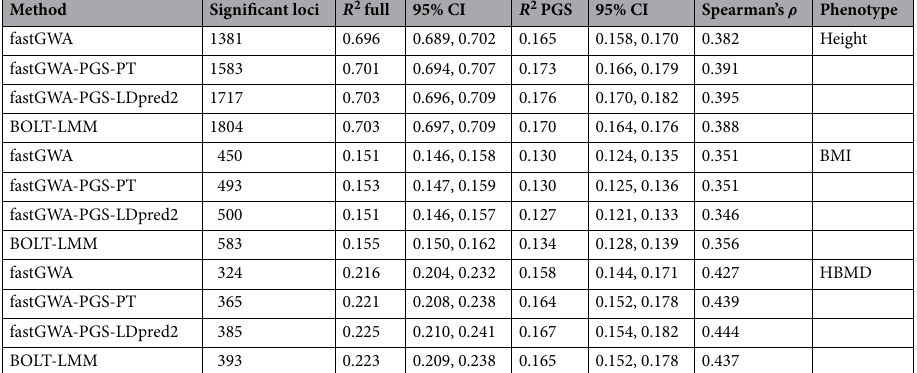
Table 2. Number of independent significant loci identified and resulting phenotype prediction model fit. R 2 full is the coefficient of determination of a model that includes the PGS, sex, age & 10 PCs as covariates 2 while R PGS is the coefficient for a model that includes only the PGS. BOLT-LMM was applied with a GRM consisting of 556,516